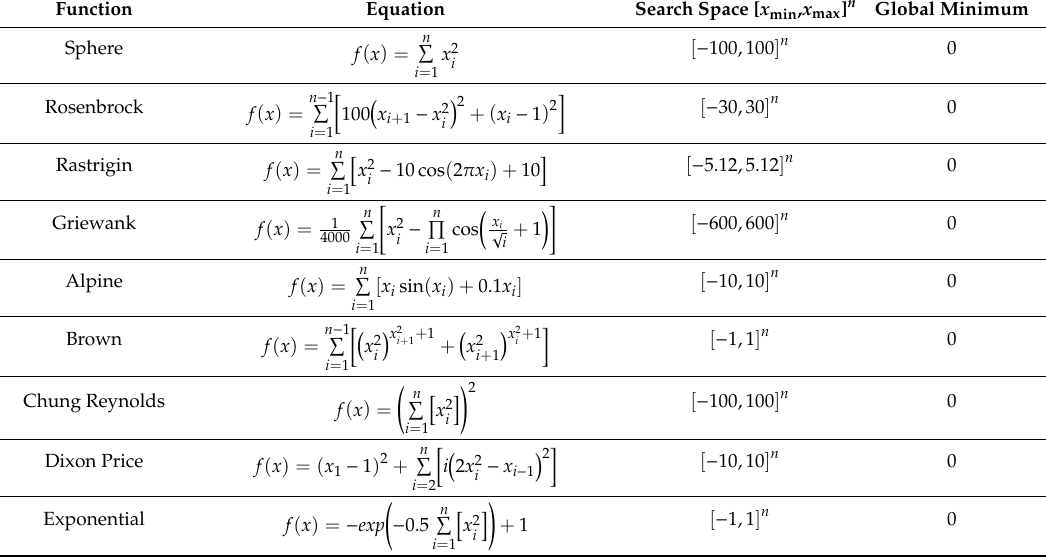
Table 2. Benchmarking